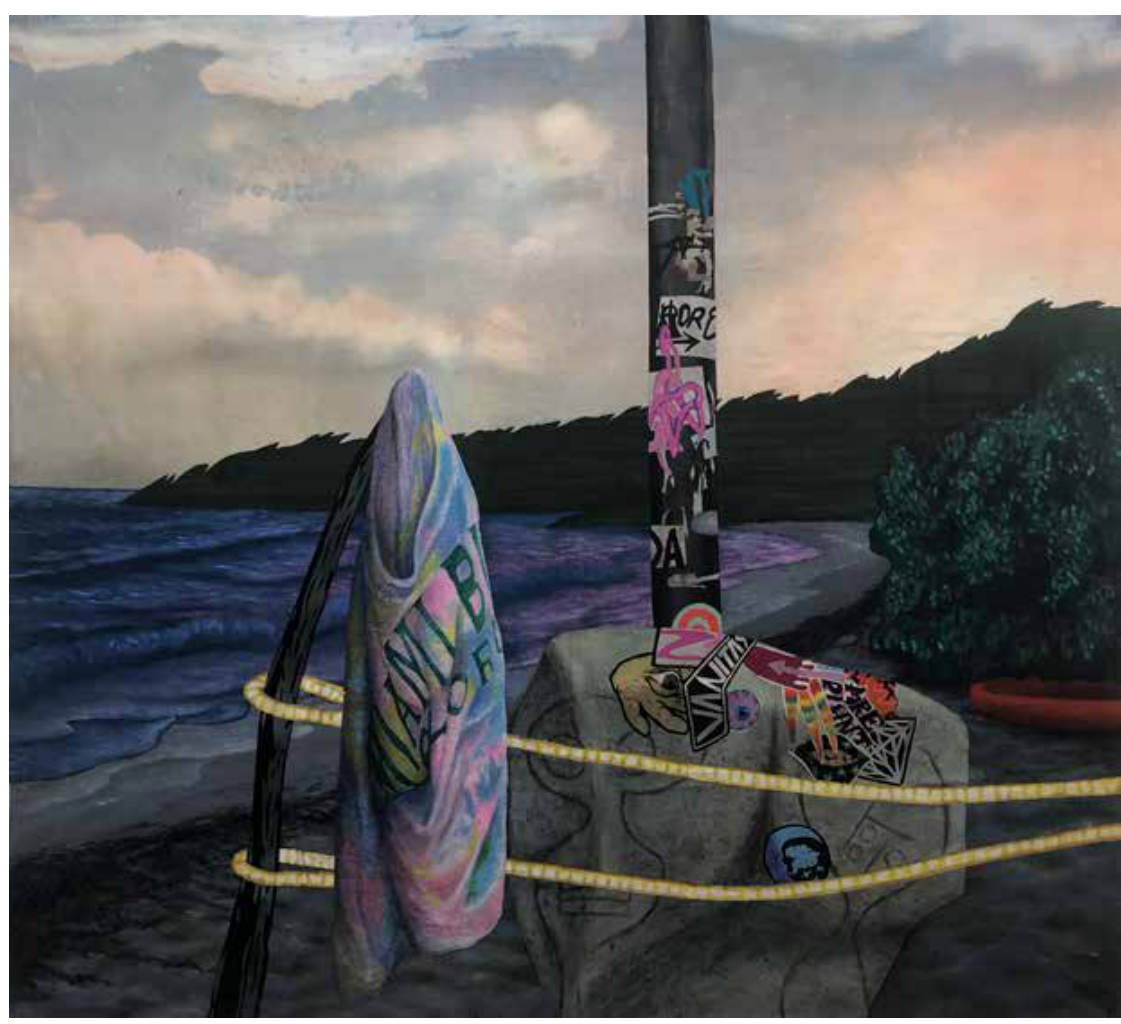
Figure 1: Denise Burge, Pablo, 2020. Paint, thread, and fabric, 152.4 x 167.6